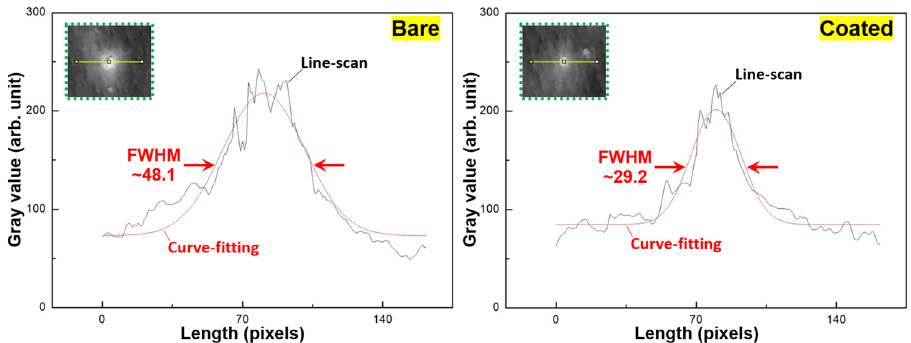
Figure 4. Line-scan gray-level pigment intensity profiles across tattoos created by bare and coated 5-needle using the profile plot tool of ImageJ software. A Gaussian function was used to fit the profile curve in red color and obtain the full width at half maximum (FWHM) pixel value of intensity profile. The profiles were obtained from areas as an example outlined by green dots shown in Fig. 3, with FWHM pixel values of 48.1 for bare and 29.2 for coated tattoos. 1 pixel is equal to ~ 25.6 µm.